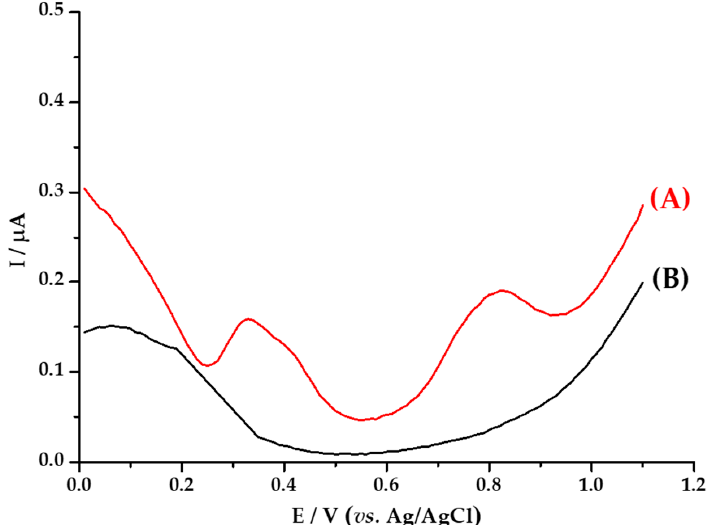
Figure 8. Differential pulse voltammetry analysis of: ( A ) M. albida extract electrode in 0.10 mol L − 1 sodium acetate solution, ( B ) blank acetate solution; on GC work electrode. Scanning rate 50 mV/s vs. Ag/AgCl at 25 °C.